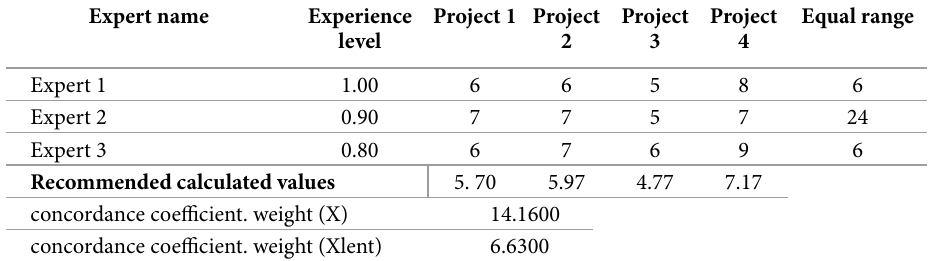
Table 2. Determination of quality indicator rating of designer of prepared projects using expert method Rating of project designers determined by expert